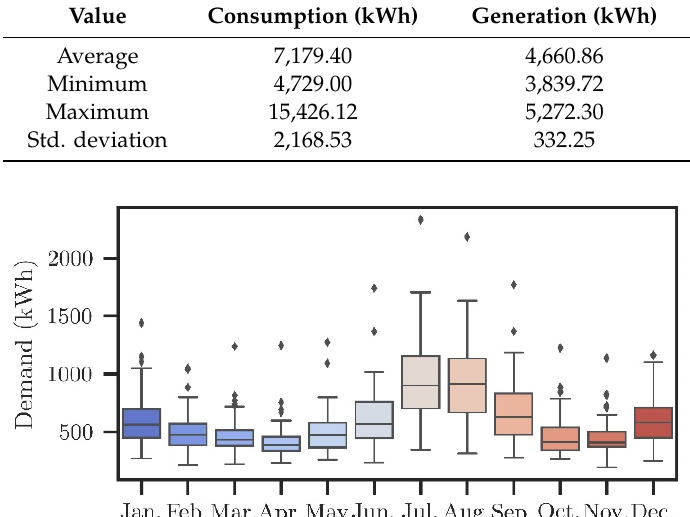
Figure 2. Household electricity demand (n = 55 ).